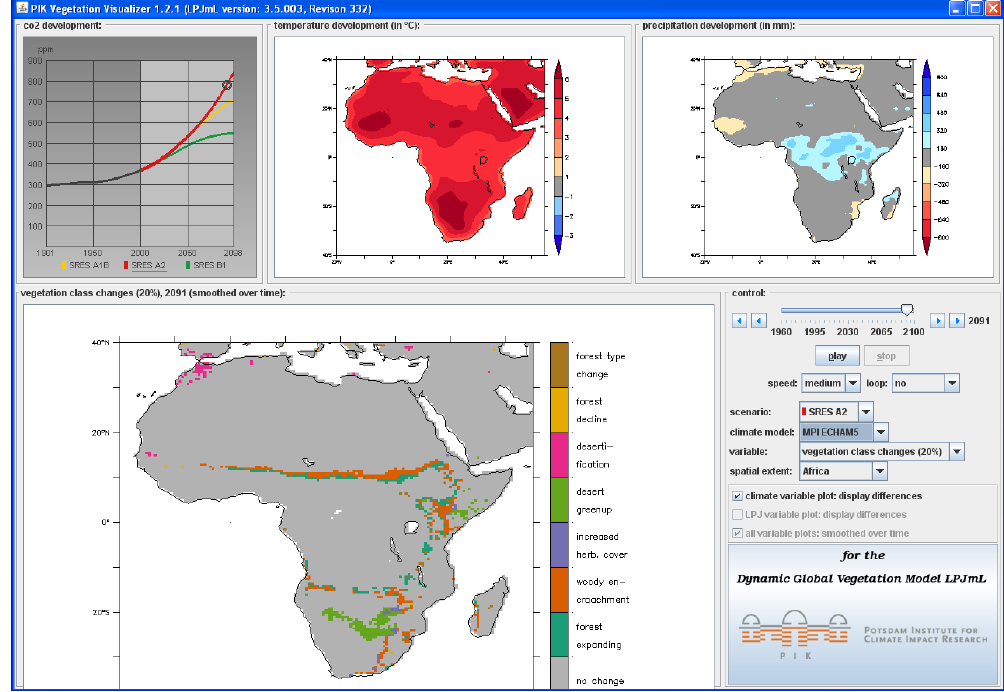
Figure 12. Screenshot of the Vegetation Visualizer tool [42] used to generate views of Africa showing temperature development, precipitation development and changes of vegetation class.